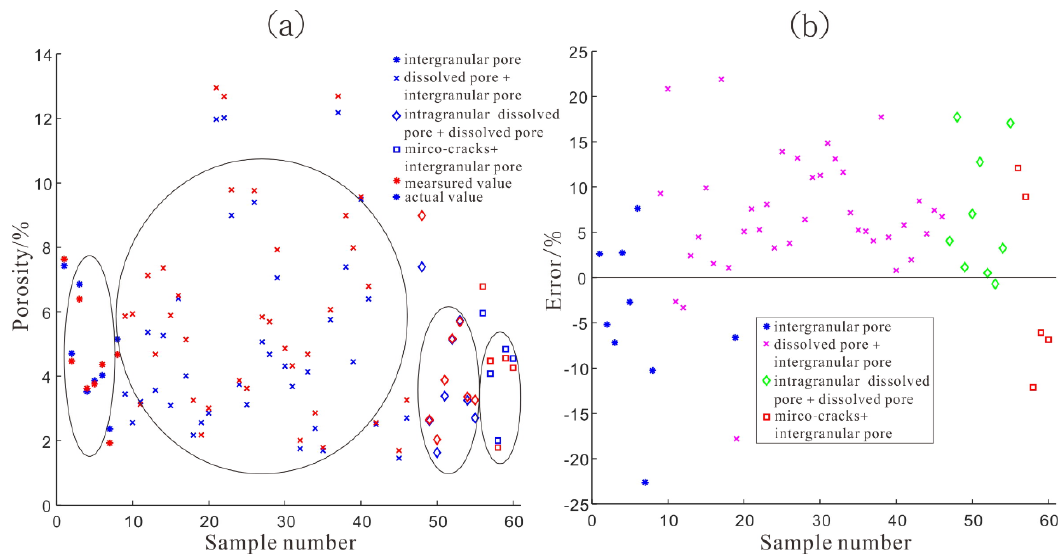
Figure 10. Porosity measurement comparison chart with two experimental methods. ( a ) the left figure shows the porosity difference of different experimental methods; ( b ) the right figure shows the error of different experimental